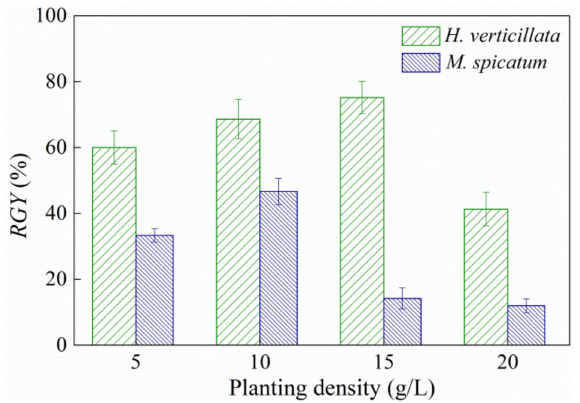
Figure 2. Relative growth yield (RGY) of submerged macrophytes with planting densities of 5 g / L to 20 g / L. Results are expressed as average ± SD ( n = 3).